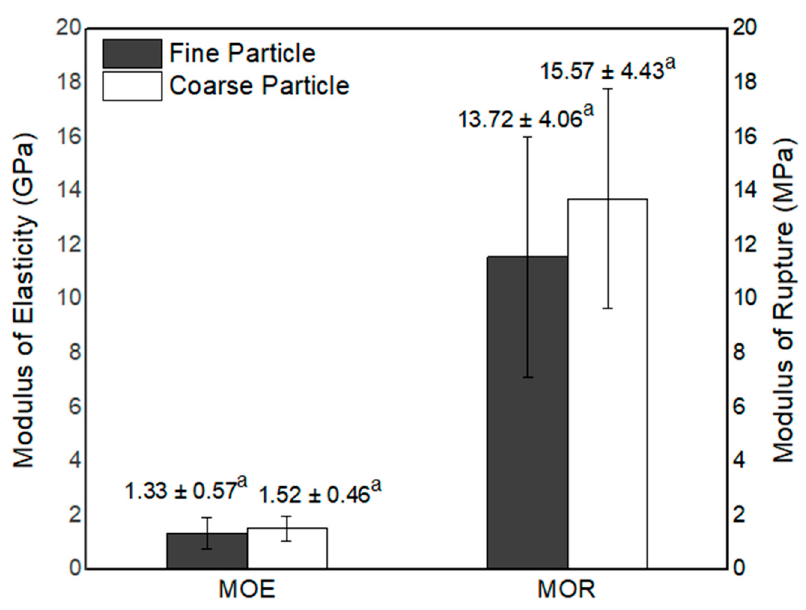
Figure 2. Bending characteristics of particleboard made with different particle sizes. Values followed by the same letters are statistically not different at p < 0.05.